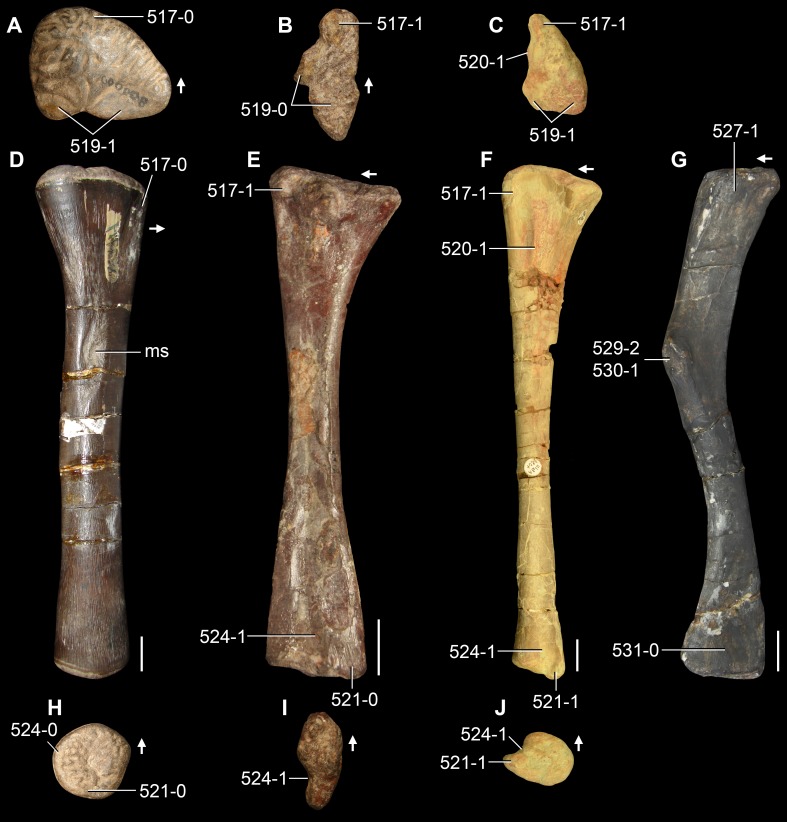
Posterior zeugopodia of Triassic archosauriforms in (A–C) proximal, (D) medial, (E–G) lateral, and (H–J) distal views.(A, D, H) Right tibia of “Chasmatosaurus” yuani (IVPP V2719, mirrored); (B, E, I) left tibia of Chanaresuchus bonapartei (PVL 4575); (C, F, J) right tibia of Silesaurus opolensis (ZPAL AbIII/403-2, 4, mirrored); and (G) left fibula of Aetosauroides scagliai (PVL 2073). Numbers indicate character-states scored in the data matrix and the arrows indicate anterior direction. Scale bars equal 1 cm.